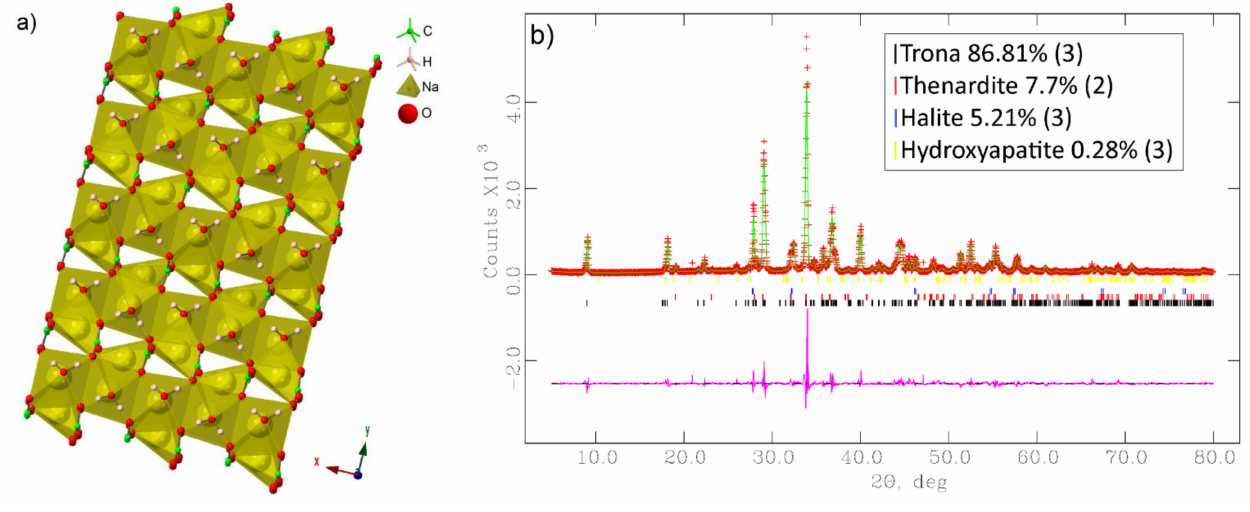
Figure 9. ( a ) Crystal structure of trona projected along the y-axis [79]. The sticks represent the C . . . O bonds and OH . . . O hydrogen bonds. ( b ) X-ray diffraction profile of the sample define as trona collected at room temperature and refined by the Rietveld method [60] with Rp. 0.11.